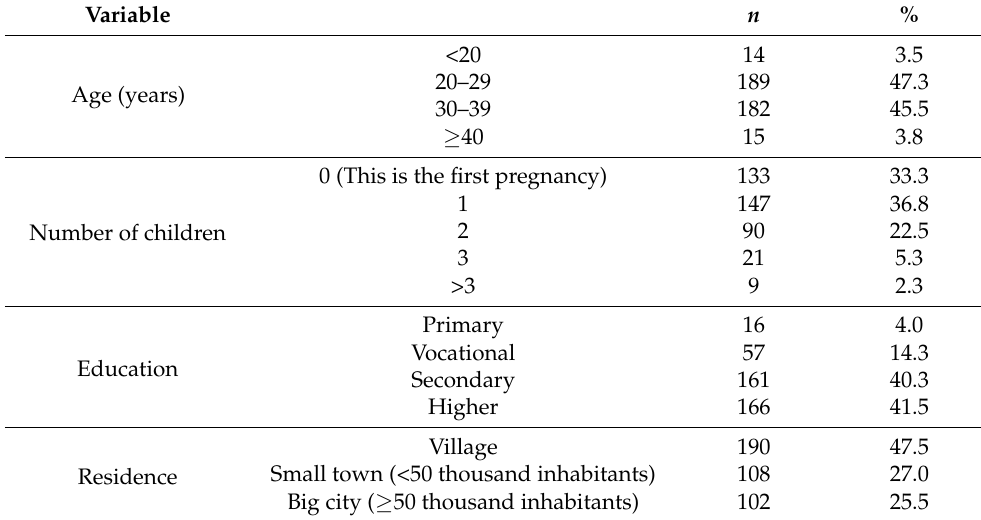
Table 1. Characteristics of the study